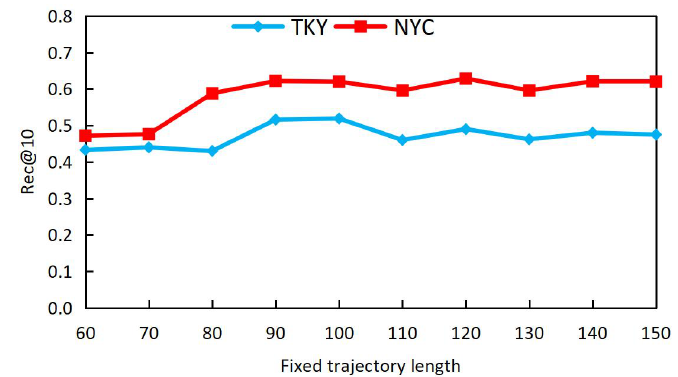
Figure 4. Performance of Rec @10 with different trajectory lengths.